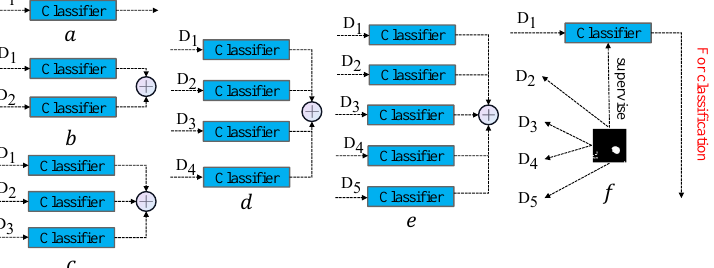
Figure 3. Comparison of different classifiers: ( a – e ) indicate that we combine the feature maps of different scales of the decoder for classification, where ( a ) is the typical classifier, ( e ) is our full-scale classifier, and ( b – d ) are in between. ( f ) indicates that the full-scale classifier is replaced by full-scale deep supervision and uses only D 1 for classification.